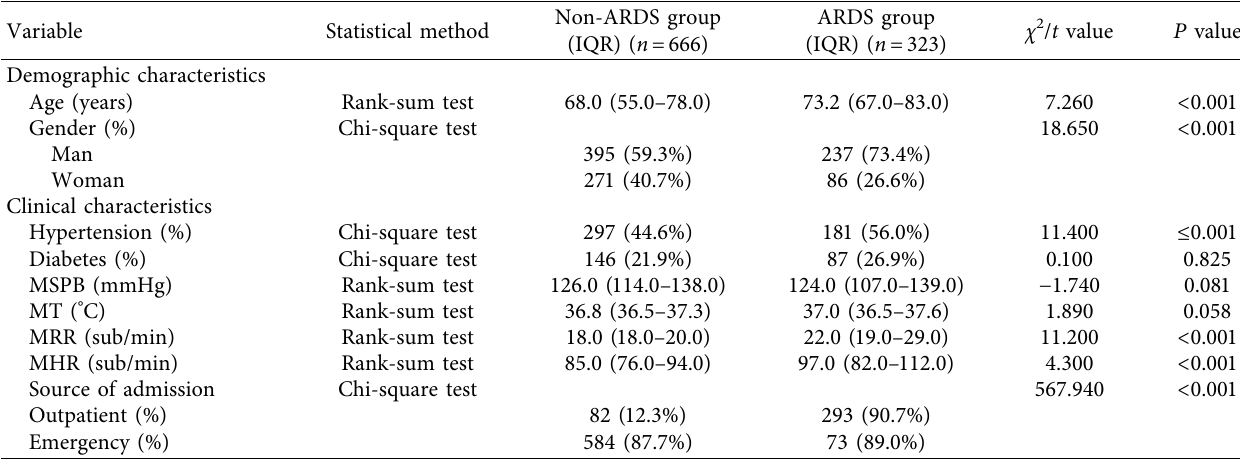
Figure 1: CAP patients enrollment according to the inclusion and exclusion criteria. Note . CAP, community-acquired pneumonia. Table 1: Univariate analysis of factors related to ARDS in CAP